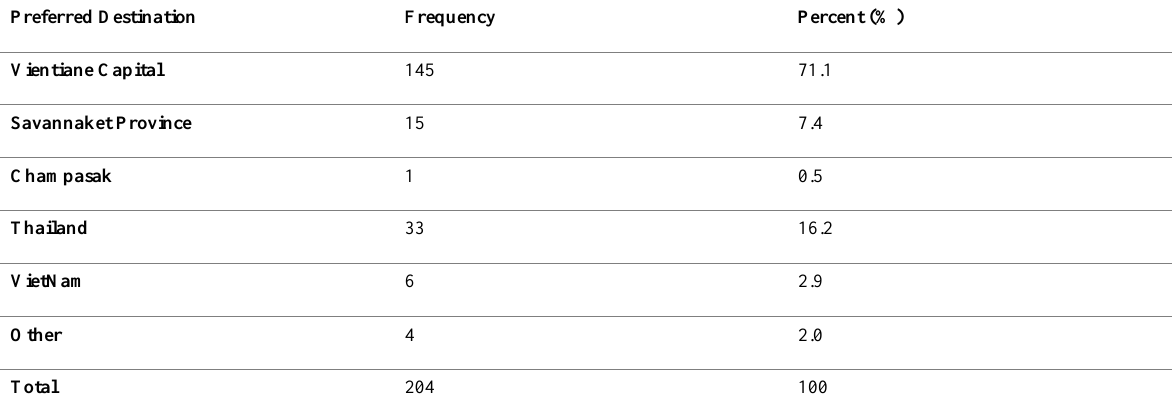
Table 2: Preferred Destinations for Migrants